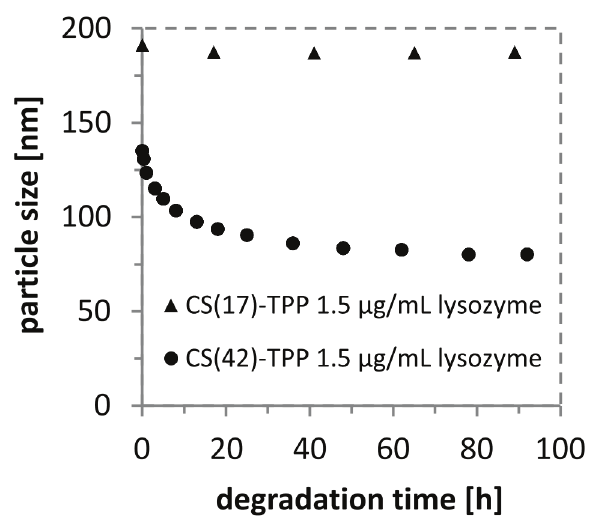
Figure 2. Plot of the particle size over the time during the degradation with 1.5 μg/mL lysozyme at 37 °C for chitosan-tripolyphosphate (3:1, 1 mg/mL, 0.075% AcOH, DA 17%) and (3:1, 1 mg/mL, 0.075% AcOH, DA 42%) nanoparticle solutions.